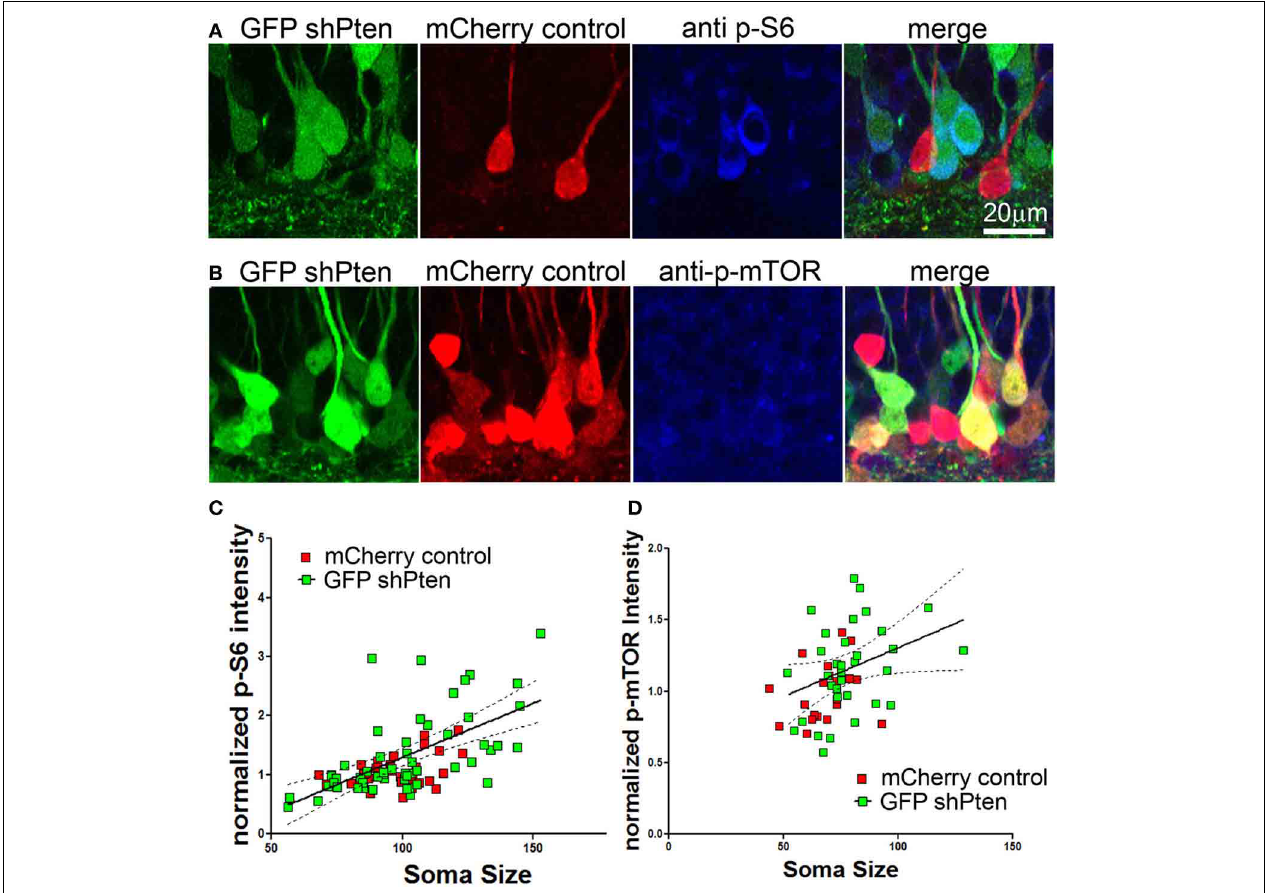
FIGURE 3 | p-S6/p-mTOR correlated to increased soma size in Pten knockdown neurons. Adult animals were co-injected with the Pten knockdown lentivirus (GFP shPten; green) and the mCherry expressing control virus (mCherry control; red) and immunohistochemistry was used to evaluate p-S6 or p-mTOR expression (blue) at 21 days post-injection. (A,B) Increased p-S6 or p-mTOR staining (blue) was observed in the GFP shPten cells (green) when compared to neighboring mCherry control cells (red) in the same histological section. (C) The fluorescence intensity of the p-S6 staining was measured and normalized to the average value obtained for control cells in each histological section. A